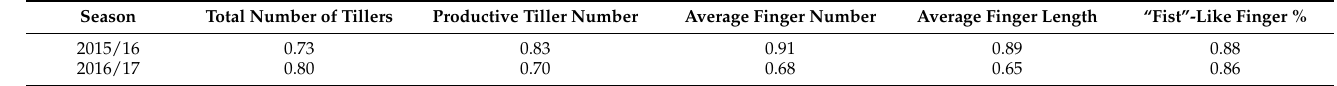
Table 3. Correlation coefficients between yield and total tillers, productive tillers, average number of fingers per panicle, finger length and “fist”-like finger percentage during the 2015/16 2016/17